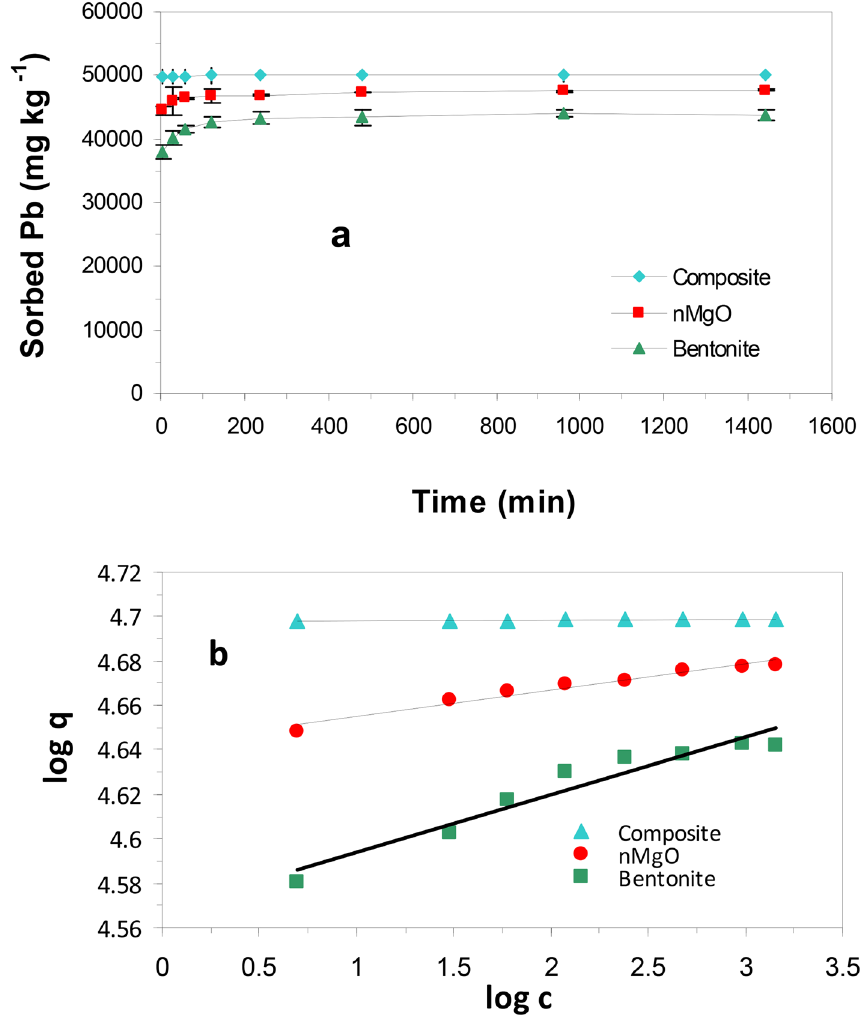
Figure 4. Kinetics of Pb(II) sorption by bentonite and nanocomposite (nMgO-bentonite) ( a ) and power function model for Pb sorption by the two sorbents ( b ) at Initial Pb concentration of 500 mg L − 1